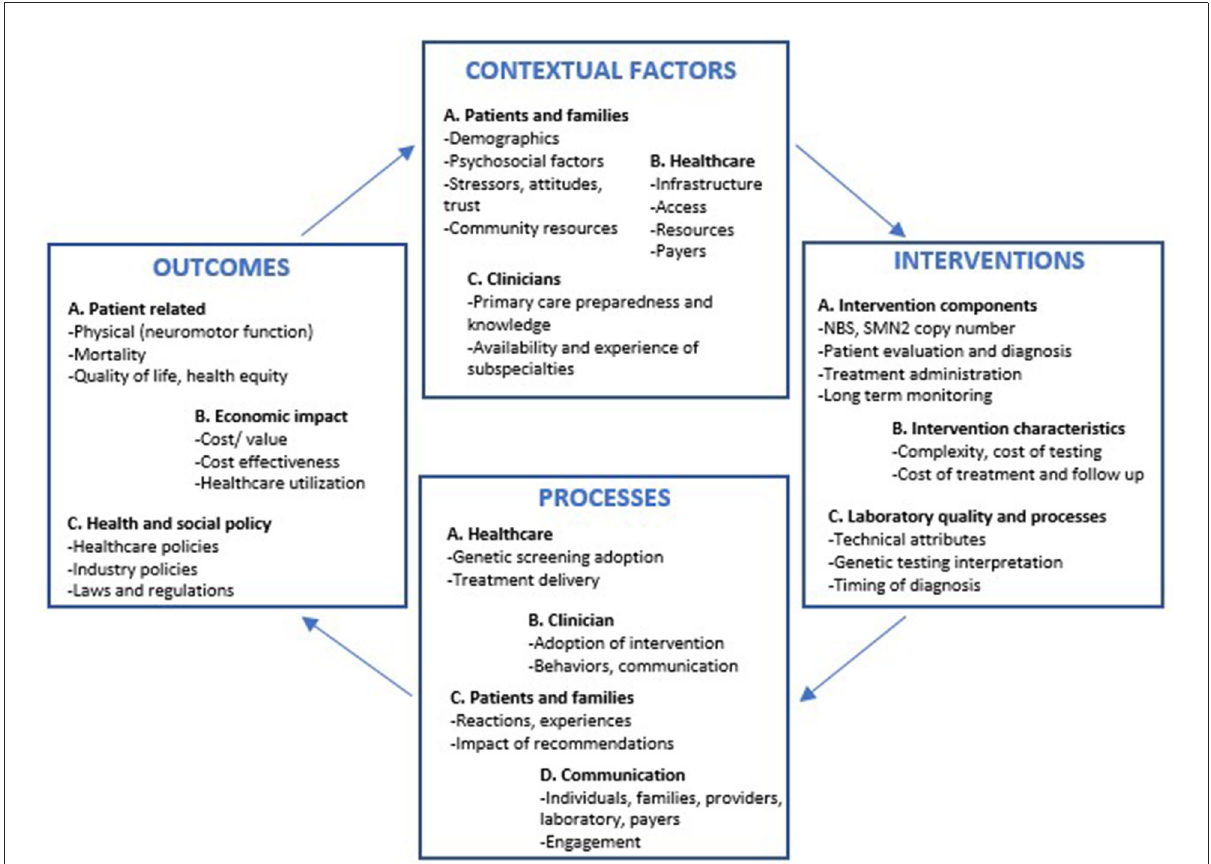
FIGURE1 GMIR framework adapted for infants with spinal muscular atrophy diagnosed via newborn screening programs. NBS, Newborn screening; SMN2, Survival motor neuron 2